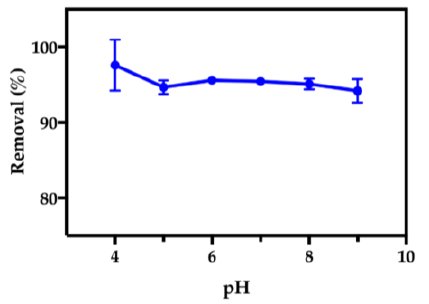
7 of 16 Table 3. Kinetic parameters estimated from pseudo 1st order, pseudo 2nd order, and Elovich models and evaluation of the respective fittings for initial paraquat concentrations ( C 0 ): 30, 60 and 90 μg/mL. C 0 (μg/mL)